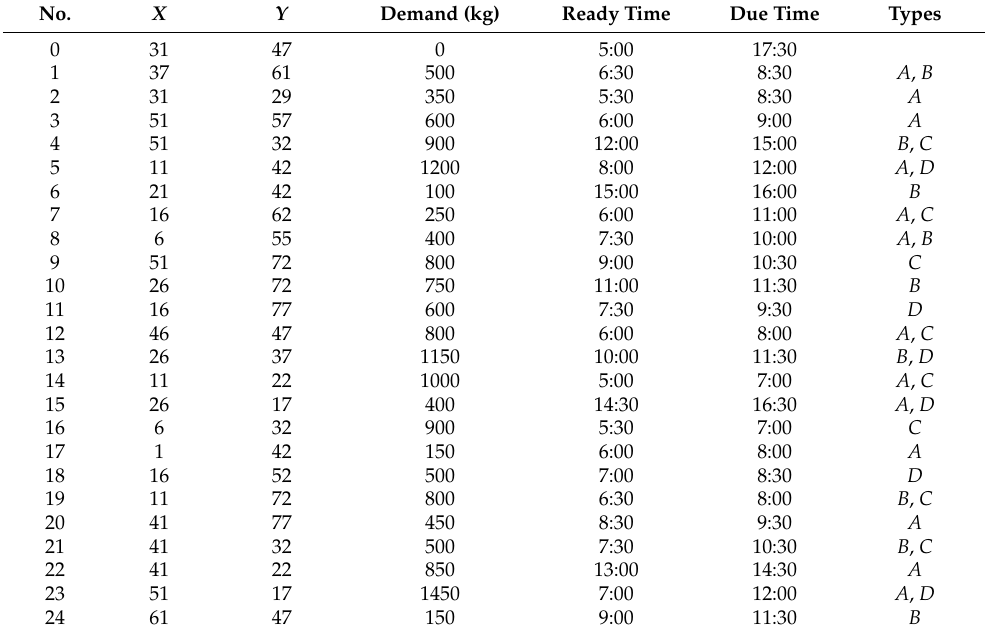
Table 6. Relevant data of distribution center and 24